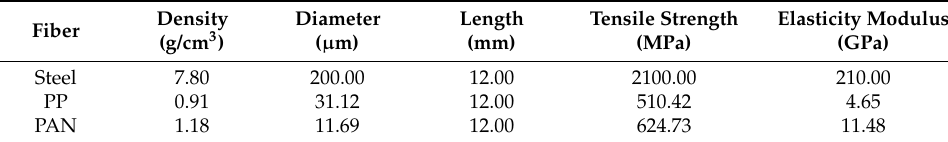
Table 2. Main parameters of the